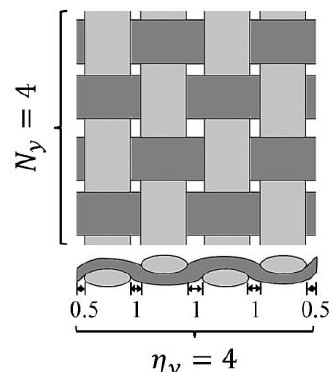
Figure 2. Illustration of inflection points.